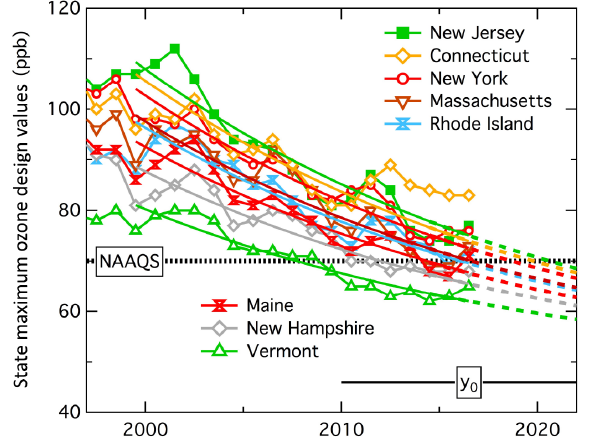
Figure 10. Time series of maximum ODVs reported from any site within each of the eight northeastern states. The solid curves are fits of Eq. (1) to the respective colored symbols for the 2000–2017 period. The derived A ∗ values from these fits are given in Table 3. The dashed lines are projections of the solid curves.